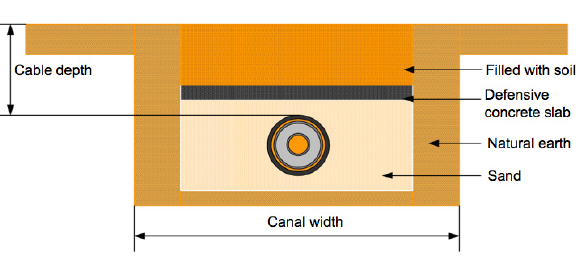
Fig. 2. Underground layout in canal.